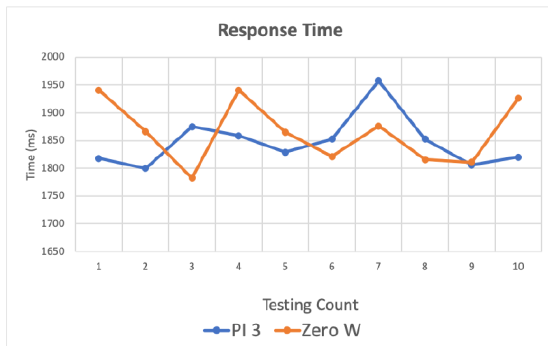
Figure 13. Response time for PI 3 and Zero W after logical control of gateway. The blue line shows that PI is both a publisher and a subscriber. The orange line shows that Zero W is both a publisher and a subscriber.